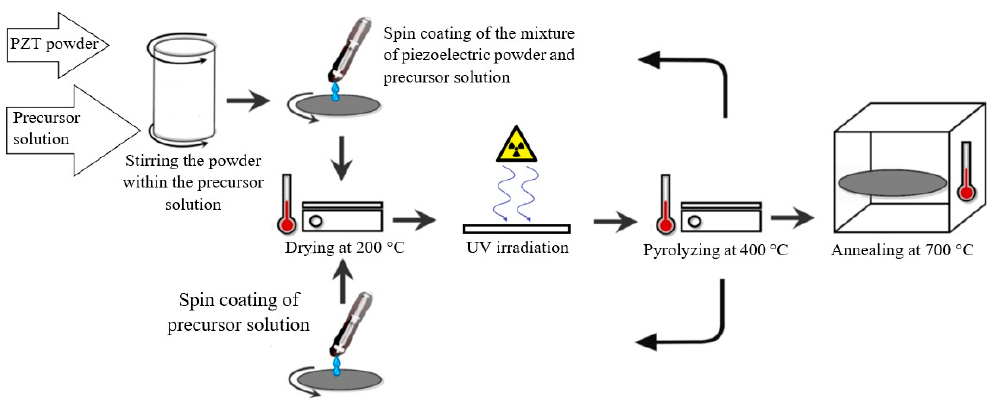
Figure 1. The consecutive steps of hybrid sol-gel deposition including the mixture of piezoelectric powder and precursor solution, injection, drying, ultra violet (UV) irradiation, pyrolyzing, and annealing.